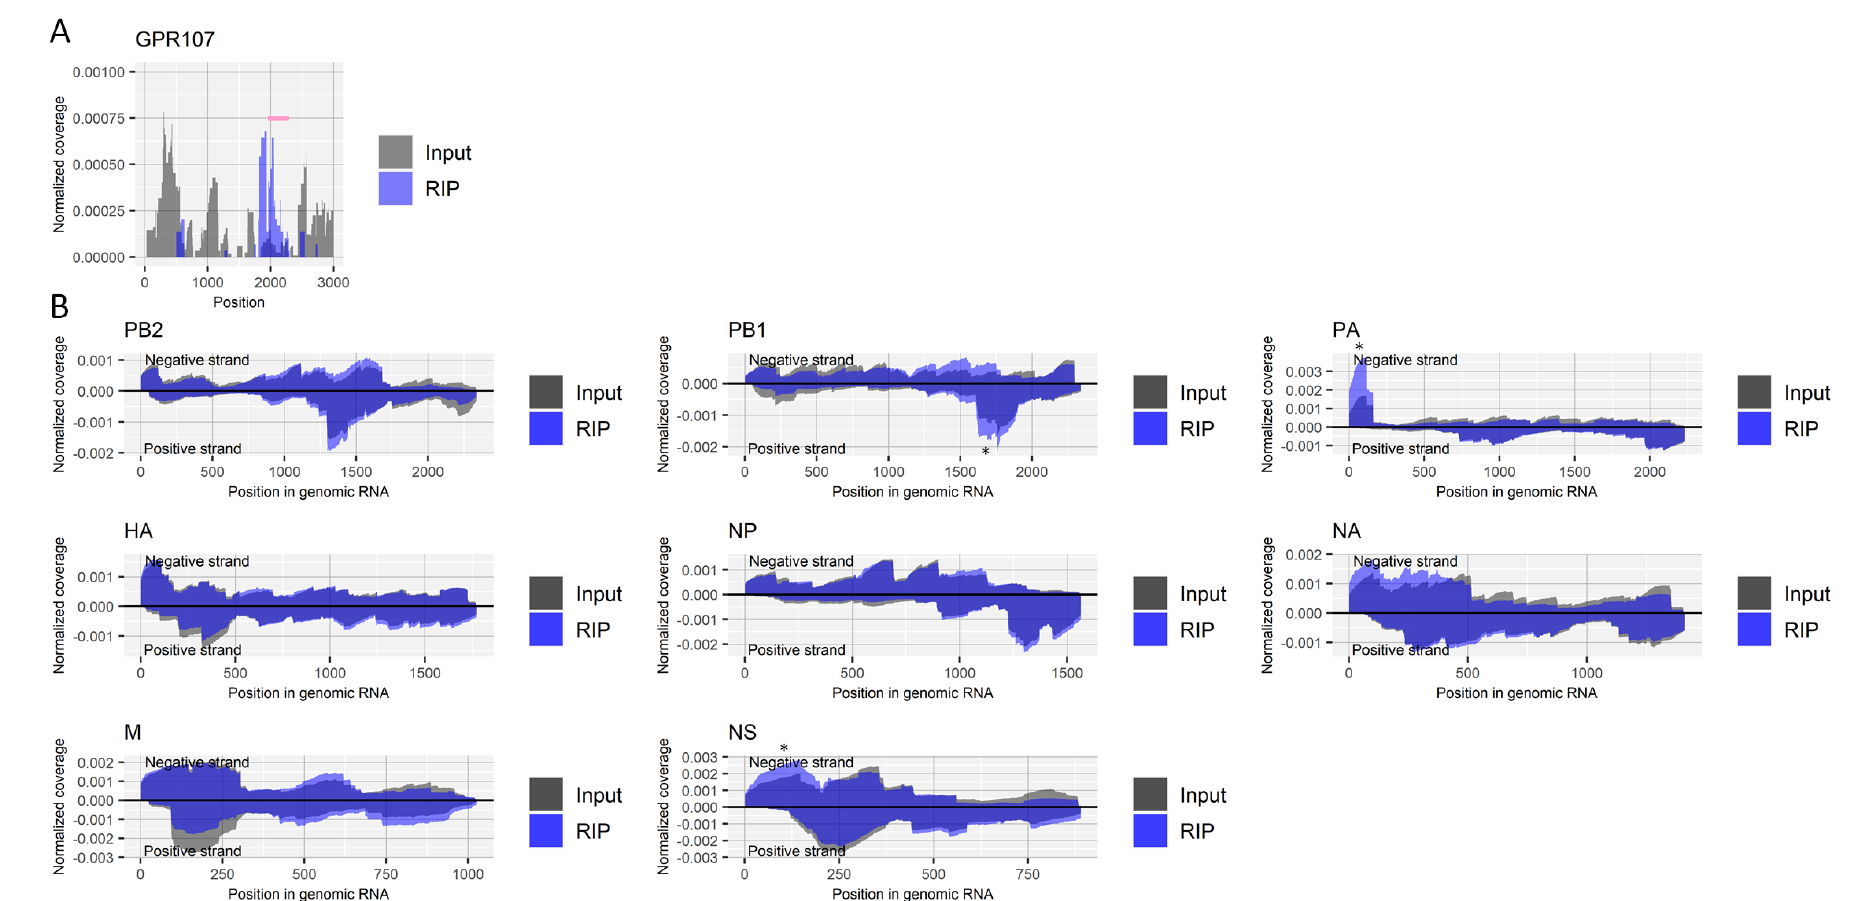
Figure 5. Search for regions that include m7G in RNA derived from influenza A virus. ( A ) Read coverage of deep-sequencing in the host’s GPR107 gene normalized by the number of read counts mapped to the transcript for RIP and input samples. A pink bar indicates a region with a possible m7G site. ( B ) Read coverage of deep-sequencing in negative-strand RNA (positive values) and positive-strand RNA (negative values) of each viral segment normalized by the number of read counts mapped to each transcript for RIP and input samples. *, non-specifically enriched region that was also observed in other experiments. Results of the biological replicate experiment are available in Supplementary Figure S5.